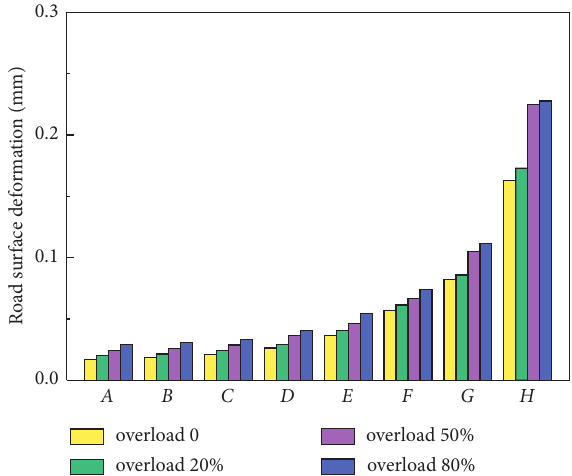
Figure 16: Impact of vehicle overload condition on road surface deformation (A ∼